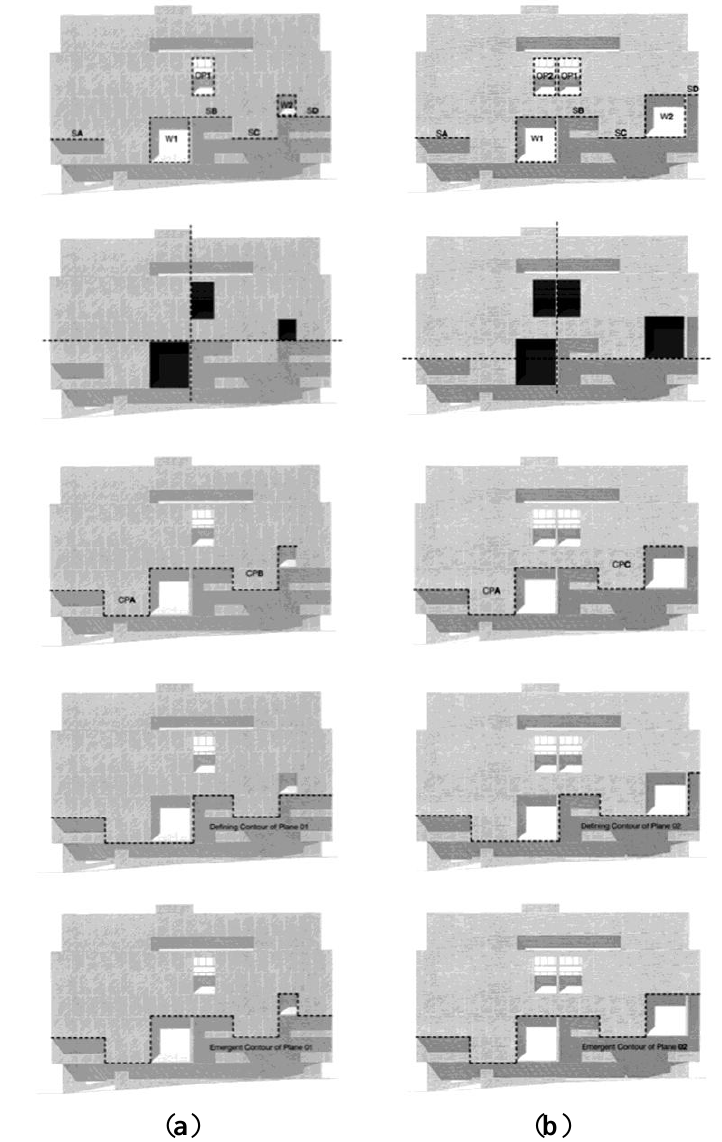
Figure 4. Façade design comparisons and coding. ( a ) Original Design; ( b ) Altered